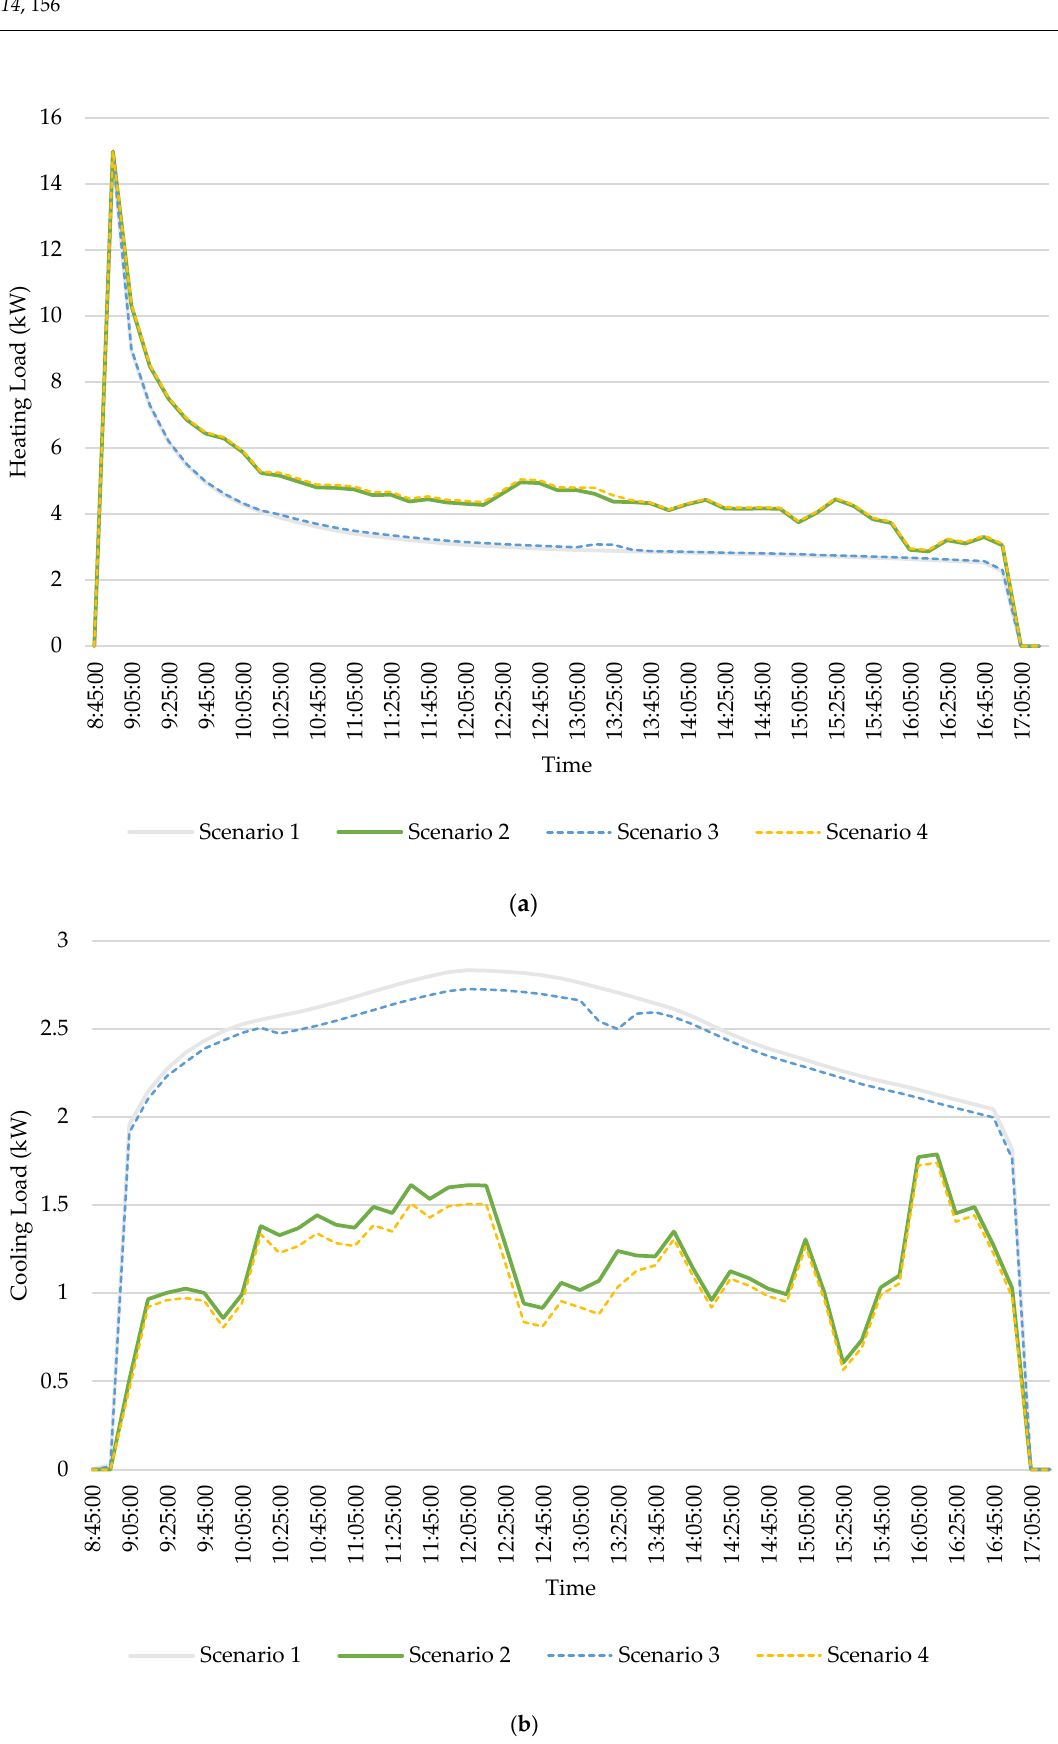
Figure 18. ( a ) Heating and ( b ) cooling building energy loads distribution for a day in the selected office space comparing Scenarios 1–4.